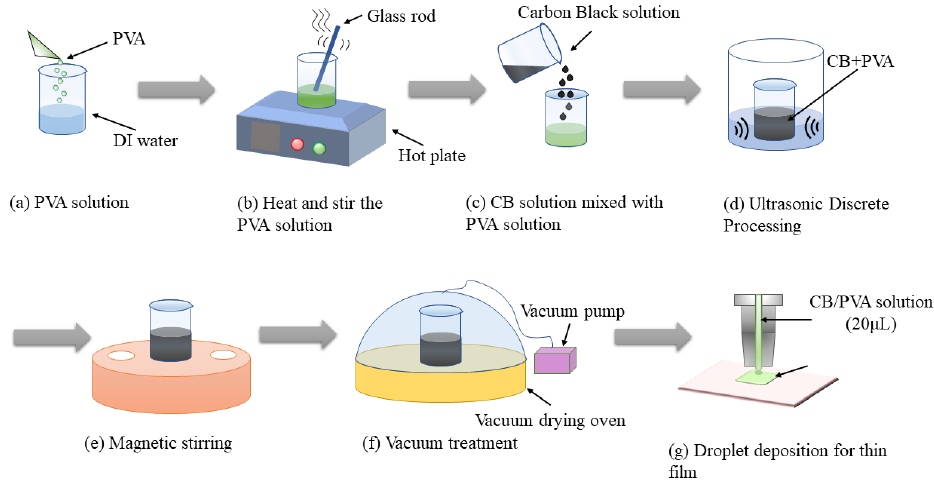
Figure 3. Schematic illustration of the preparation steps for the flexible CB/PVA film.